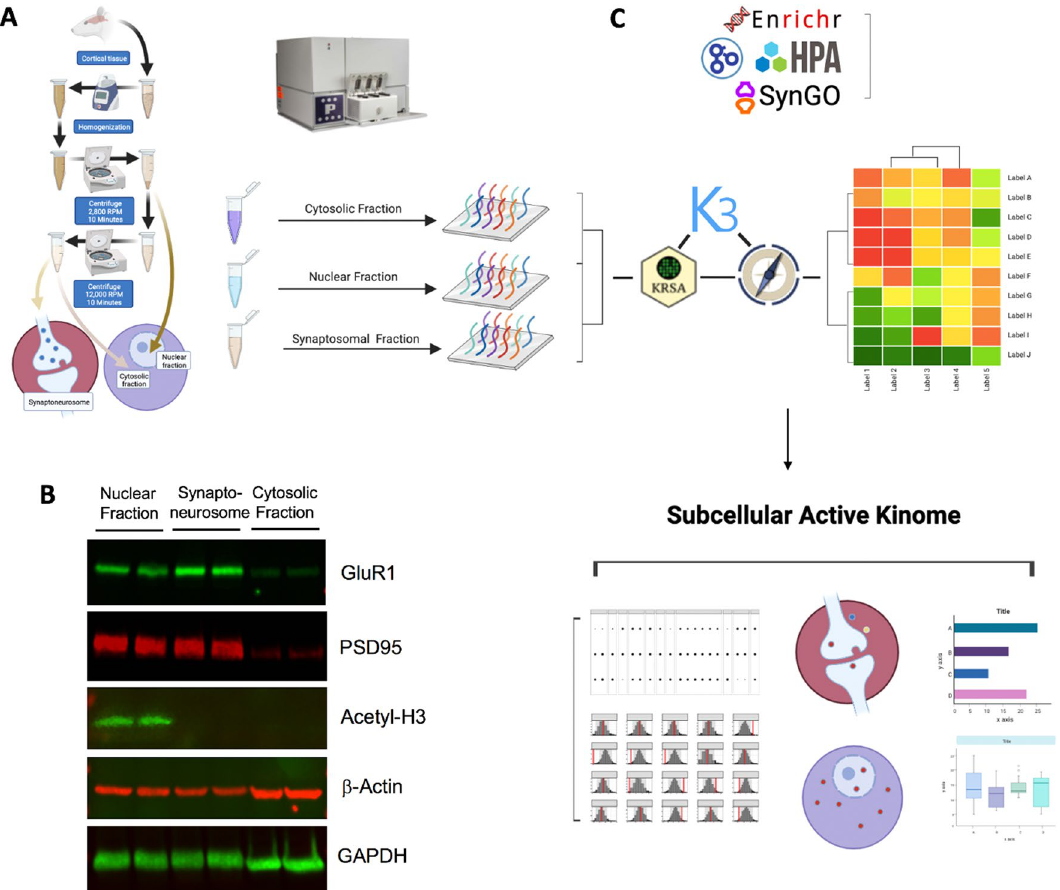
Figure 1. Subcellular Active Kinome Profiling Workflow. ( A ) General steps to isolate nuclear, cytosolic, and synaptoneurosome fractions from rat cortical tissue, as described in Materials and Methods. ( B ) To confirm the subcellular enrichment, three fractions were examined by Western blotting for levels of synaptic proteins GluR1 and PSD95, a nuclear protein acetyl Histone3, and proteins that are evenly distributed across compartments, b-actin and GAPDH. ( C ) Fractionated samples are profiled using the PamStation12 platform for high- assessment of kinase activity. The Serine/Threonine PamChip4 reporter peptides were clustered using unsupervised hierarchical clustering to identify differences between the samples. Three software packages were used to analyze the kinome array data and identify differentially active upstream kinases; KRSA, KEA3, and UKA. Other publicly available tools and databases (Enrichr, HPA, SynGo, GO) are used to perform gene set, pathway, and protein localization enrichment analysis. KRSA: Kinome Random Sampling Analyzer, KEA3: Kinase Enrichment Analysis, UKA: Upstream Kinase Analysis, HPA: Human Protein Atlas, GO: Gene